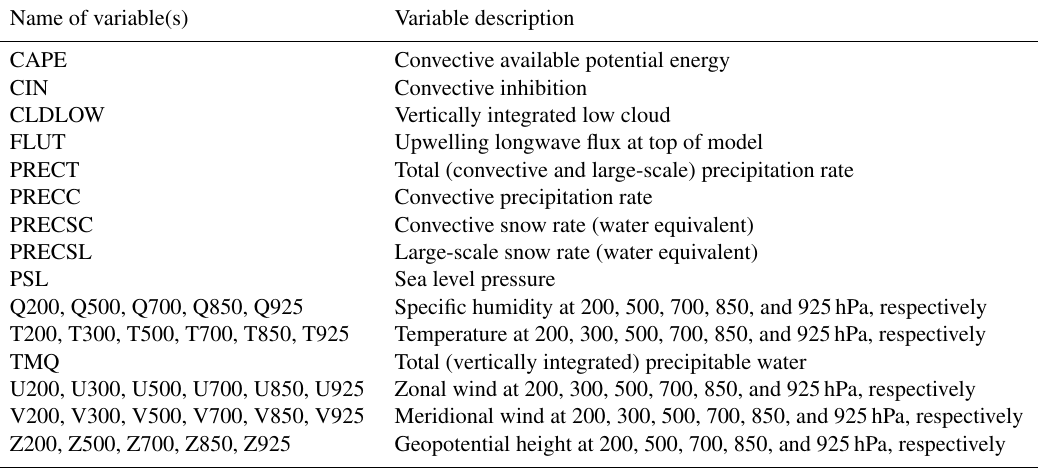
Table A3. 3-hourly averaged output from the atmospheric model in ARISE-SAI-1.5 simulations and five additional SSP2–4.5 CESM2(WACCM6) simulations. None of the above output is contained in the first five ensemble members of CESM2(WACCM6) SSP2–4.5 simulations.